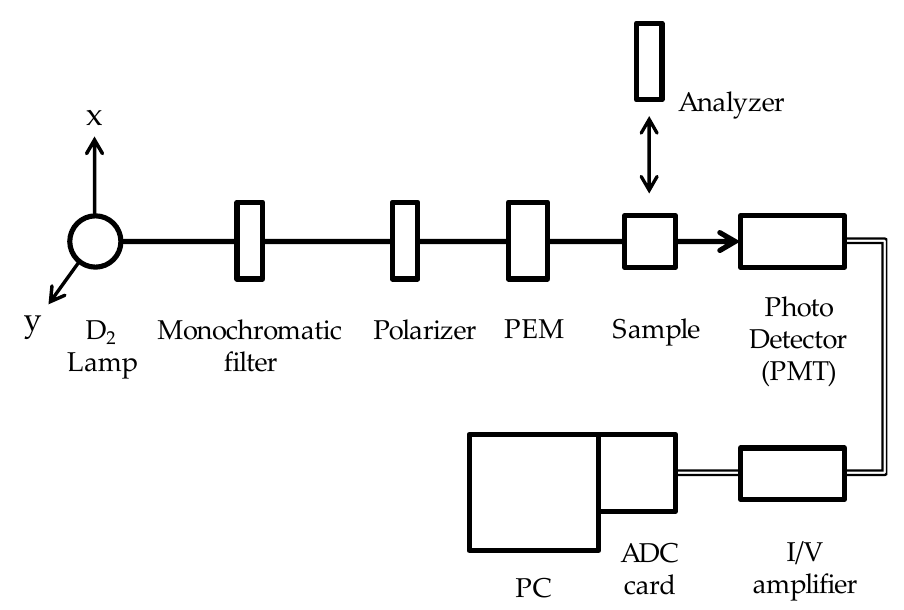
Figure 1. Block diagram of the circular dichroism (CD) measurement system for experiments. (PEM = photoelastic modulator).